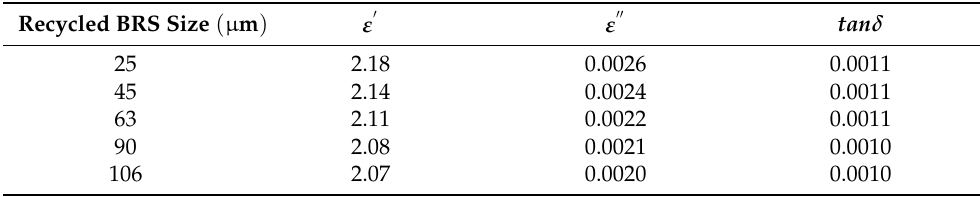
Table 2. Mean complex permittivity and loss tangent of PTFE/recycled BRS composites at different filler